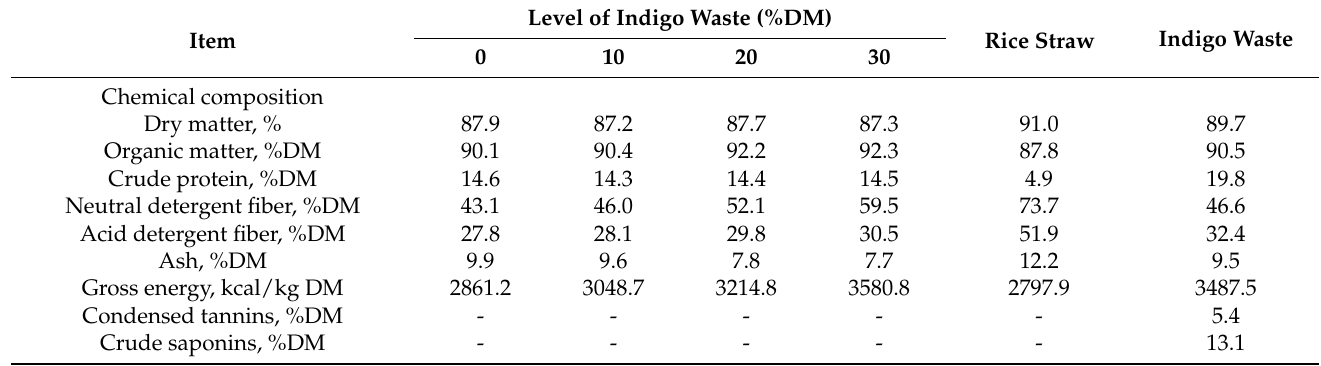
Table 3. Chemical composition of concentrate, rice straw and indigo waste.